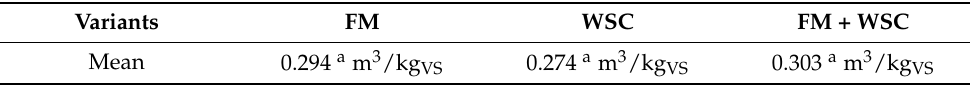
Table 8. Results of Tukey’s HSD test for the parameter of average methane yield after 35 days of the experiment.